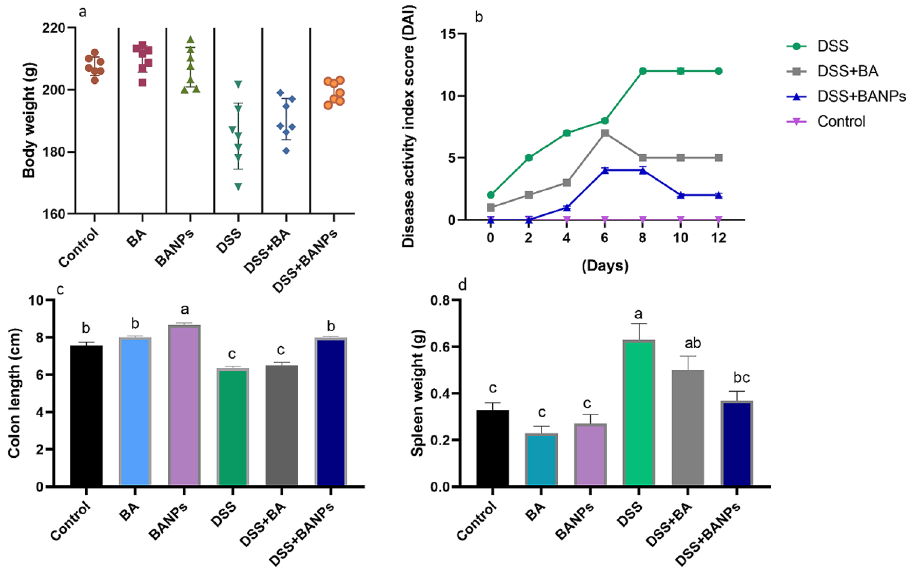
Figure 1. Effects of orally administered B. amyloliquefaciens (BA) or BA-nanoparticles (BANPs) in non- colitic and colitic Signs. ( a ) Body weight gain. ( b ) Disease activity index score. ( c ) Colon length. ( d ) Spleen weight. Non-colitic groups including Control, BA and BANPs groups where rats were orally gavaged PBS, B. amyloliquefaciens and B. amyloliquefaciens loaded nanoparticles (BA at level of 1.0 × 10 10 CFU/kg in 1 mL of PBS/rat/day), respectively, for 7 days. Colitic groups: DSS, BA and BANPs groups where rats were orally gavaged dextrane sodium sulphate (DSS), B. amyloliquefaciens + DSS and B. amyloliquefaciens loaded nanoparticles (BA at level of 1.0 × 10 10 CFU/kg in 1 mL of PBS/rat/day) + DSS , respectively, for 7 days. All groups orally gavaged by 5% DSS. Values are expressed as mean ± SE, a,b,c Means of the bars with different letters were significantly different among groups ( P <